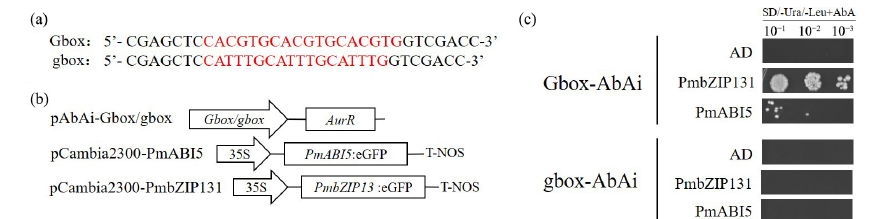
Figure 10. Single hybridization of PmABI5 with G ‐ box in yeast. ( a ) Structures of G ‐ box and g ‐ box in the pAbAi vector. Letters in red represent the three copies of G ‐ box (CACGTG) and the mutanted sequence g ‐ box (CATTTG). ( b ) Effector and reporter constructs used in yeast one ‐ hybrid assay. ( c ) PmABI5 and PmbZIP131 bind directly to G ‐ box.